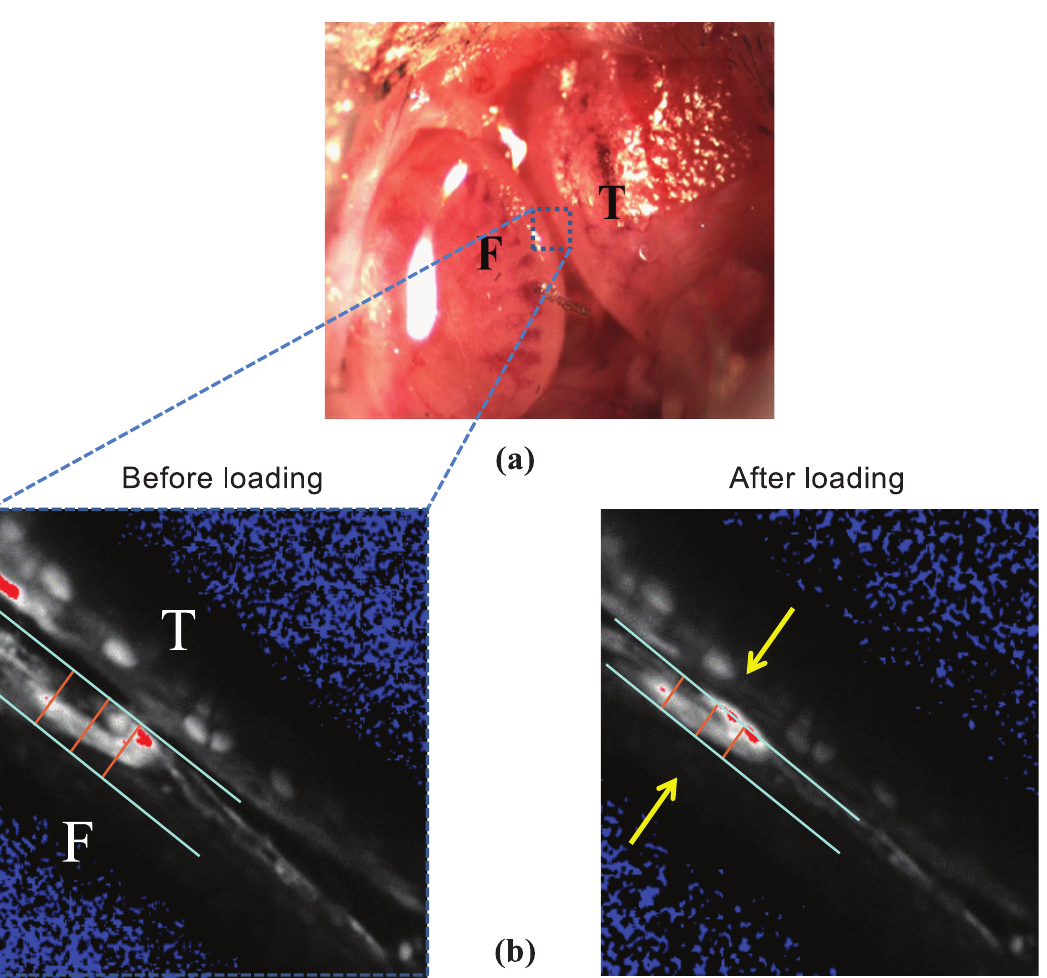
Fig 1. (a) Exposed mouse knee preparation showing the medial tibial plateau (T), and the medial femoral condyle (F) with the meniscus removed. (b) Tibio- femorol cartilage-on-cartilage space decreased to zero during muscular loading. Arrows show cartilage deformation